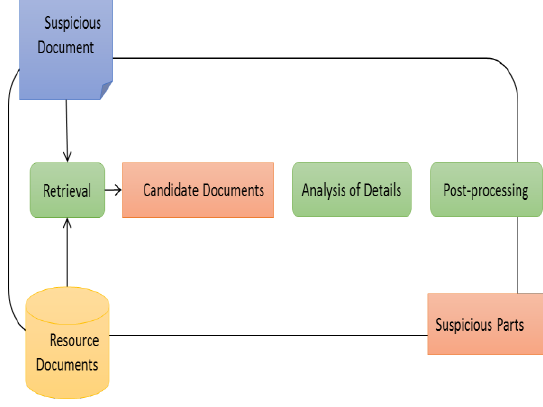
Figure 3. External plagiarism detection framework